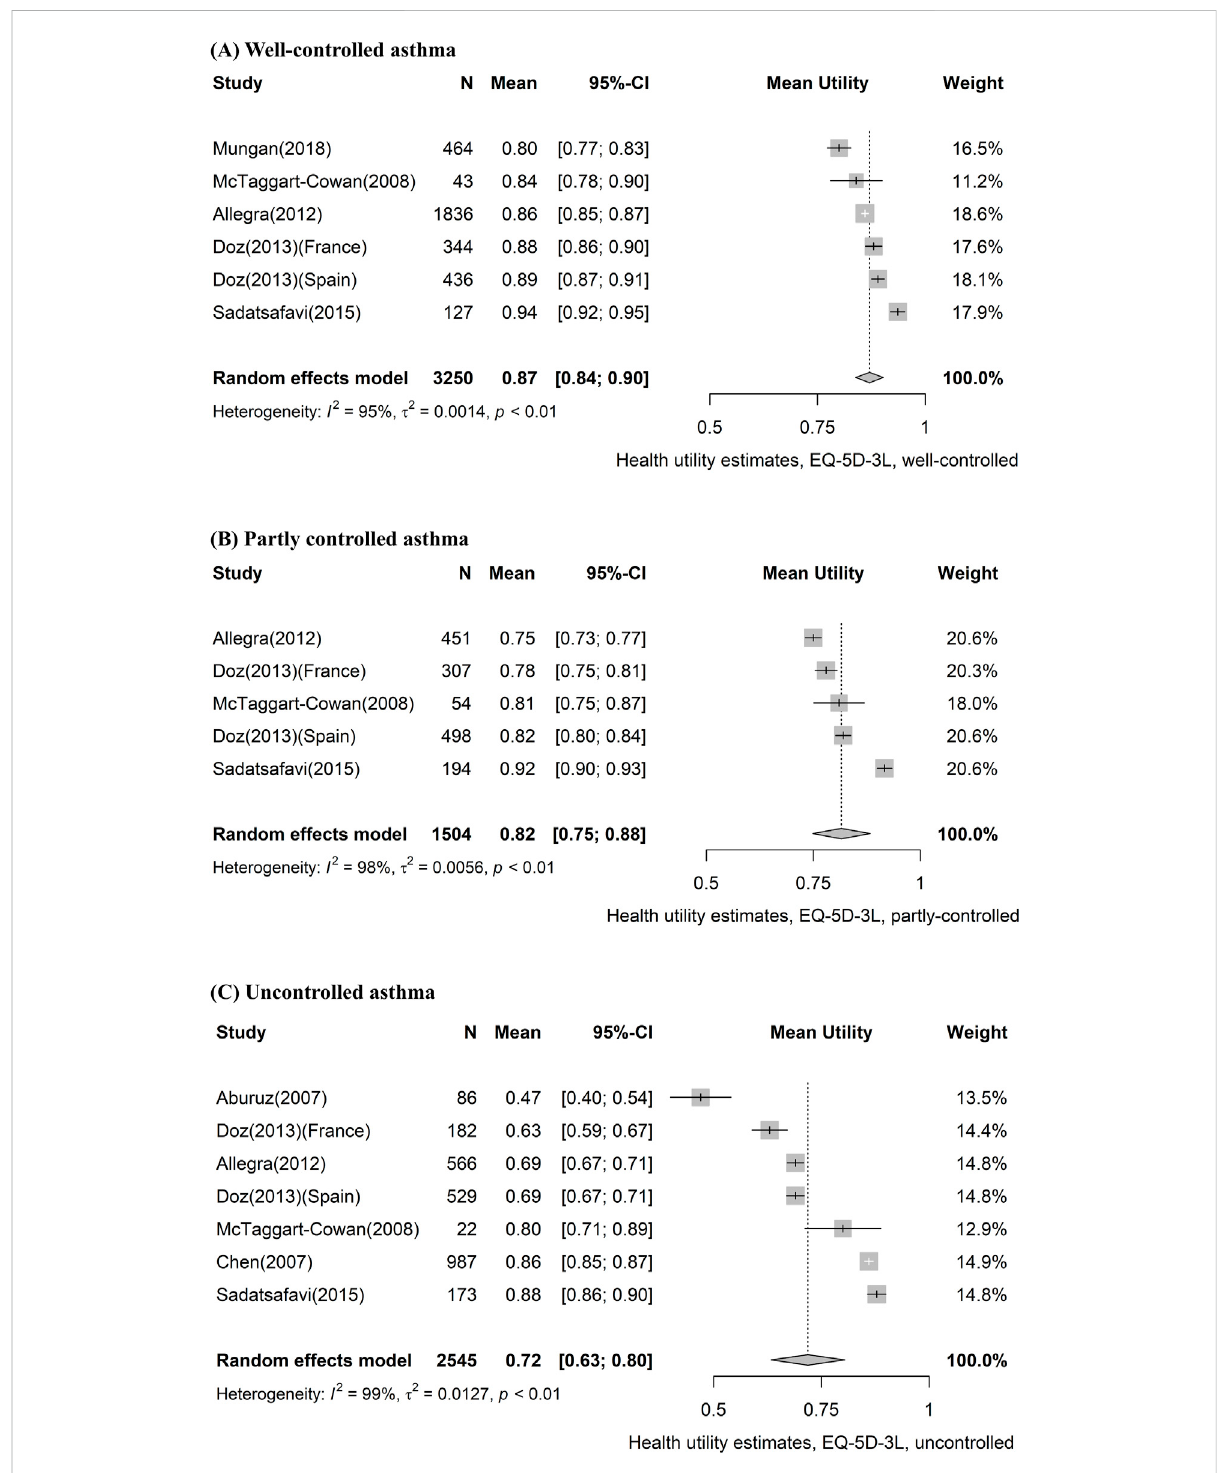
FIGURE 3 Forest plotof asthma utilitystrati fi edbycontrol level, usingthe EQ-5D-3L instrument. (A) Well-controlled asthma, (B) partly controlled asthma, and (C) uncontrolled asthma. CI, con fi dence interval; EQ-5D-3L, EQ-5D-3-level